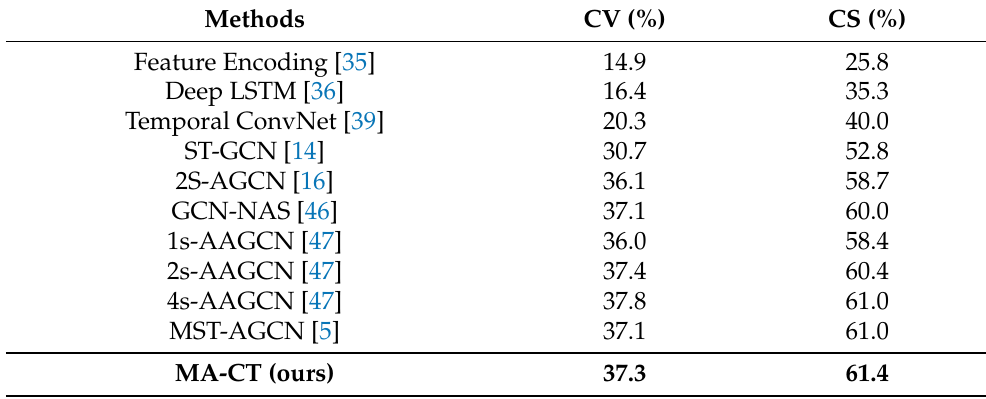
Table 4. Comparison of accuracy between ours model and other models on Kinetics-Skeleton